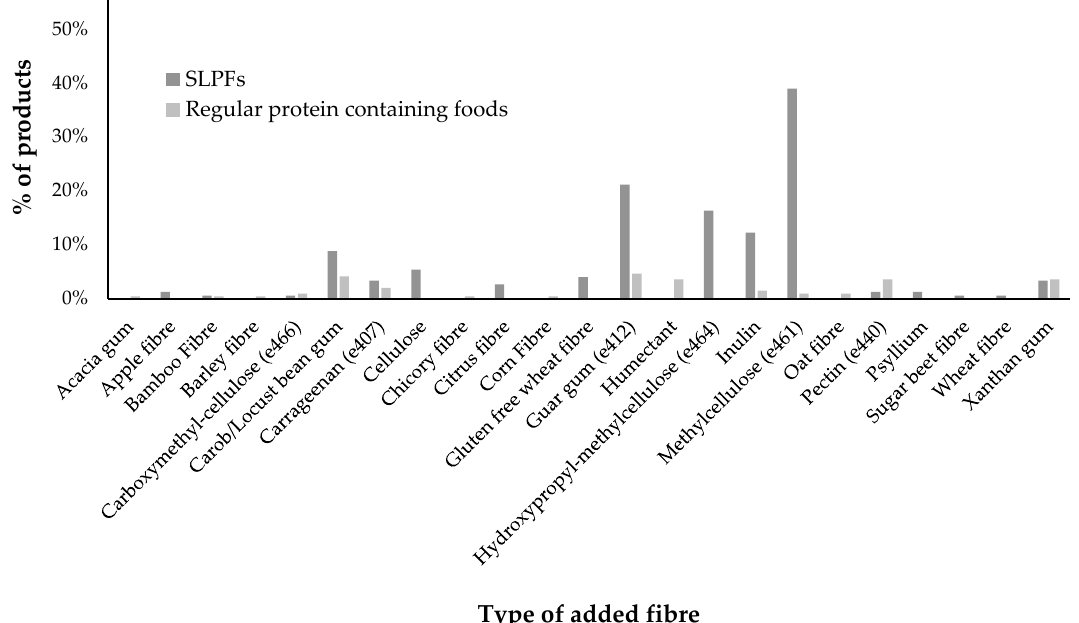
Figure 3. Percentage of regular and SLPF products containing added fibre in their ingredient lists by type of fibre.